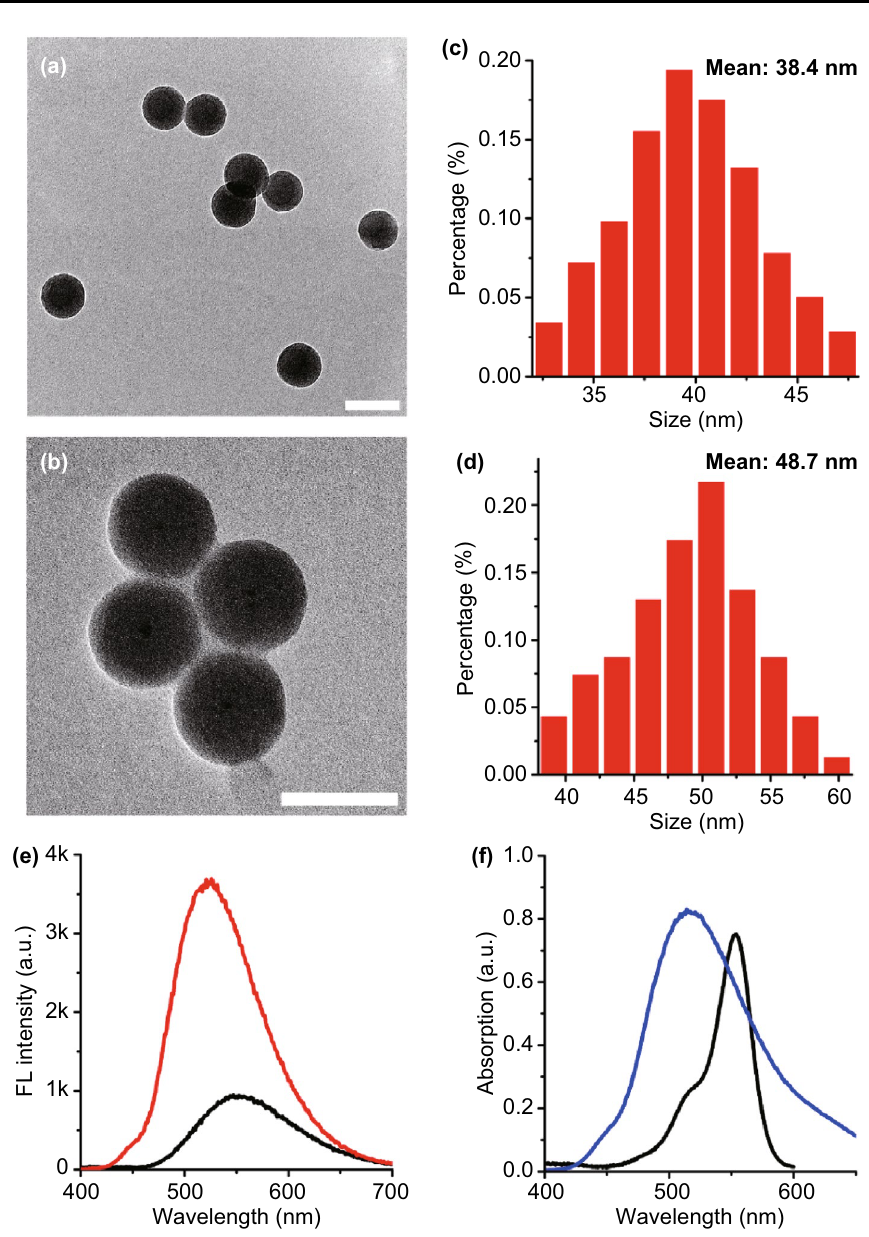
Fig. 1 TEM image of a PPD and b sPPDN. Scale bar: 50 nm. Size distribution of c PPD and d sPPDN. e Fluorescent spectra of PPD (red) in PBS solution and DNS dye (black) in DMSO under 365 nm wavelength light excitation. f Fluorescent spectra of PPDN (blue) under 365 nm wavelength excitation and absorption spectra of Rb